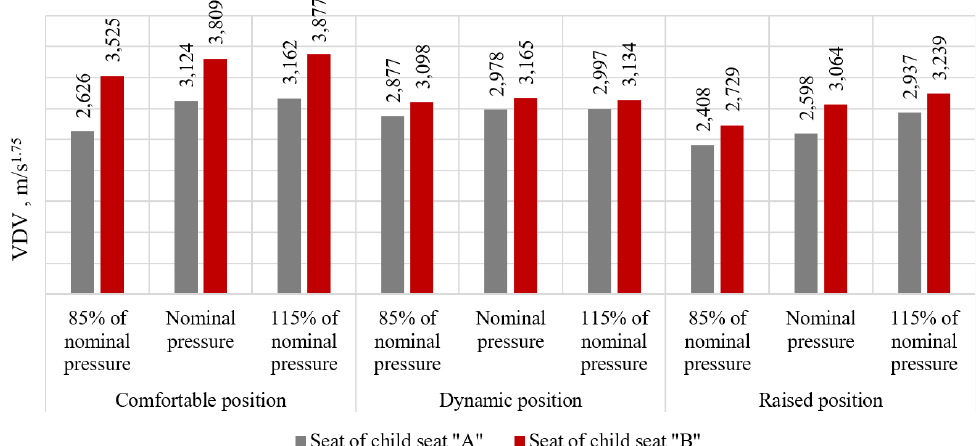
Figure 14: VDV index for the tested seats, loaded with a mass of 10 kg during the tests